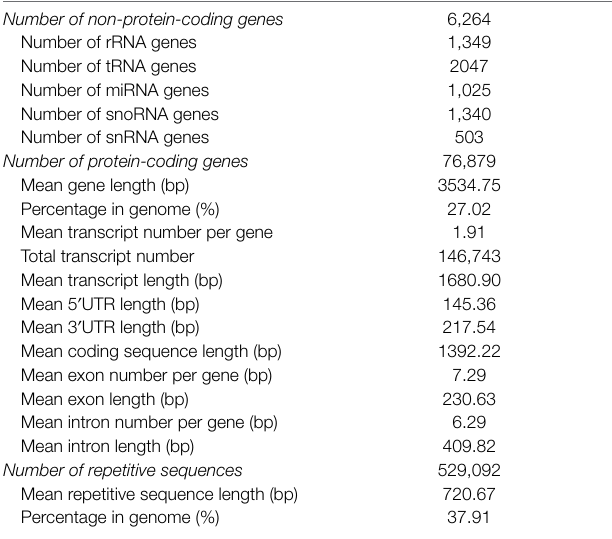
TABLE 2 | Statistics of C. dactylon genome annotation. Number of non-protein-coding